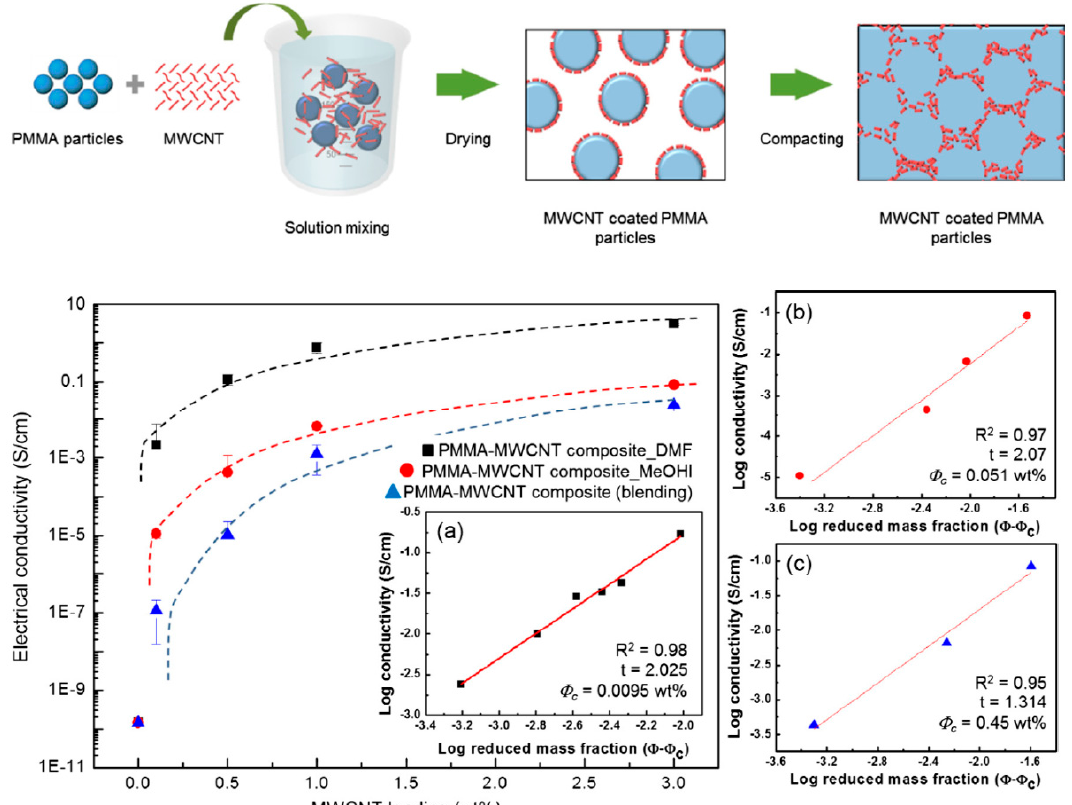
Figure 21. Method used to make the PMMA/MWCNT composites and conductivity variation of the composite as a function of MWCNT content (wt%). The fitting plots of the composites using ( a ) DMF, ( b ) MeOH, and ( c ) random blending method by the scaling relation of log σ vs. log( φ – φ c) [20].